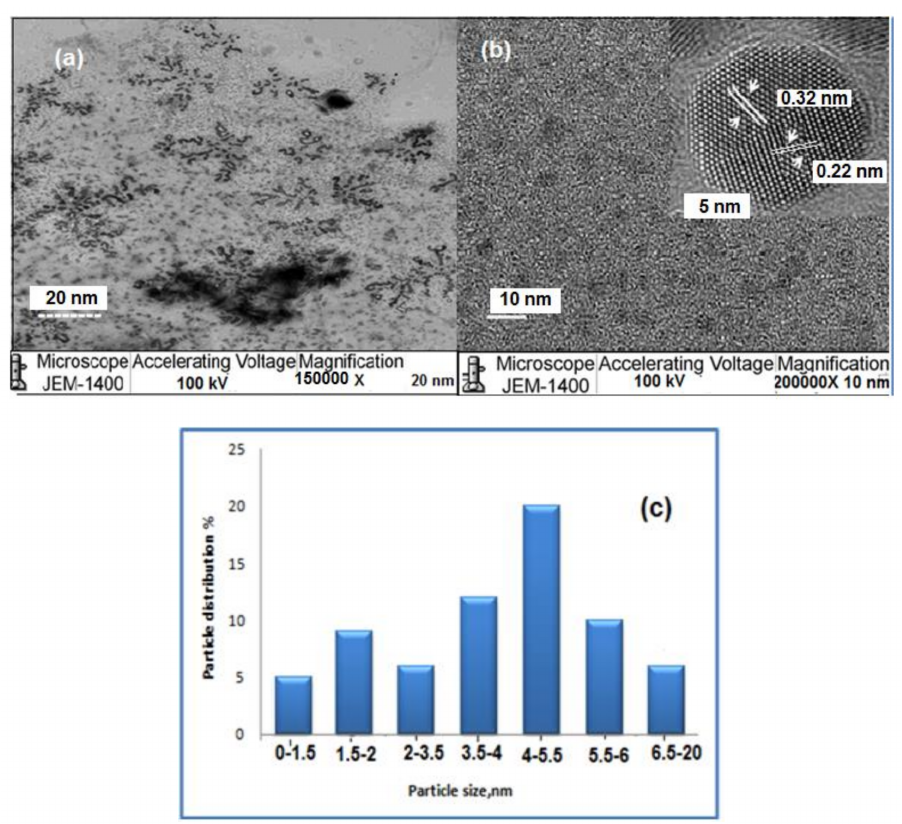
Figure 1. ( a ) TEM image of carbon quantum dots (CQDs), ( b ) High-resolution transmission electron microscopy (HRTEM) image of the spherical morphology of mono-dispersed particles with an average diameter of 5 nm and ( c ) the particle size distribution curve of the